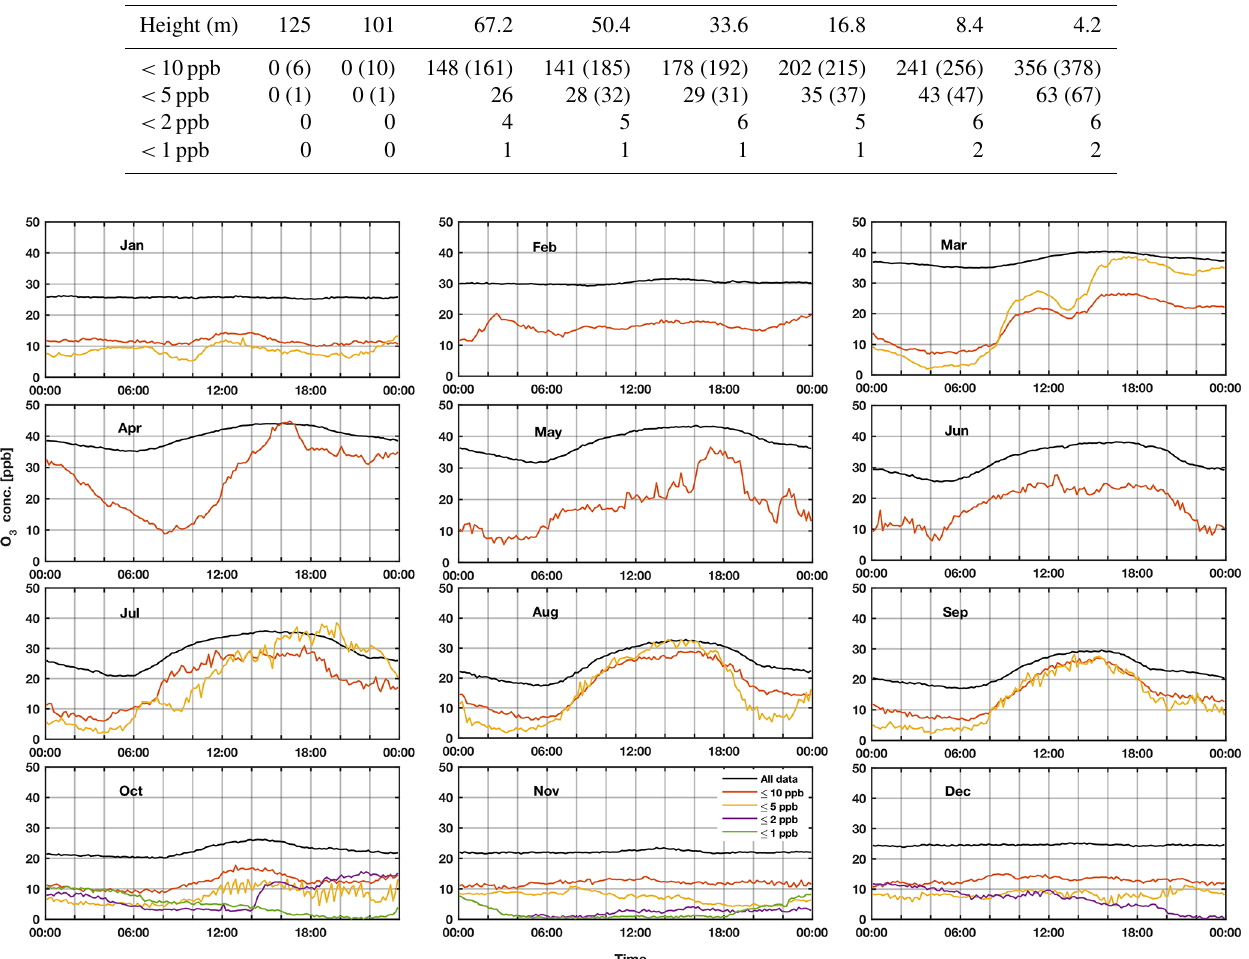
Figure 6. Diurnal patterns in median ozone concentrations at 4.2m in different months, from all the data (black), from below-10ppb depletion events (red), from below-5ppb depletion events (orange), from below-2ppb (purple) and from below-1ppb (green). A minimum duration threshold of 3h was used to select days with ozone depletion events, based on the gap-filled